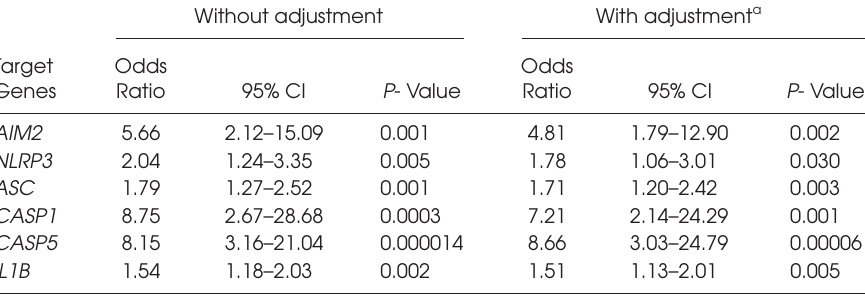
Table 3. Logistic regression to identify independent variables associated with male sex. Without